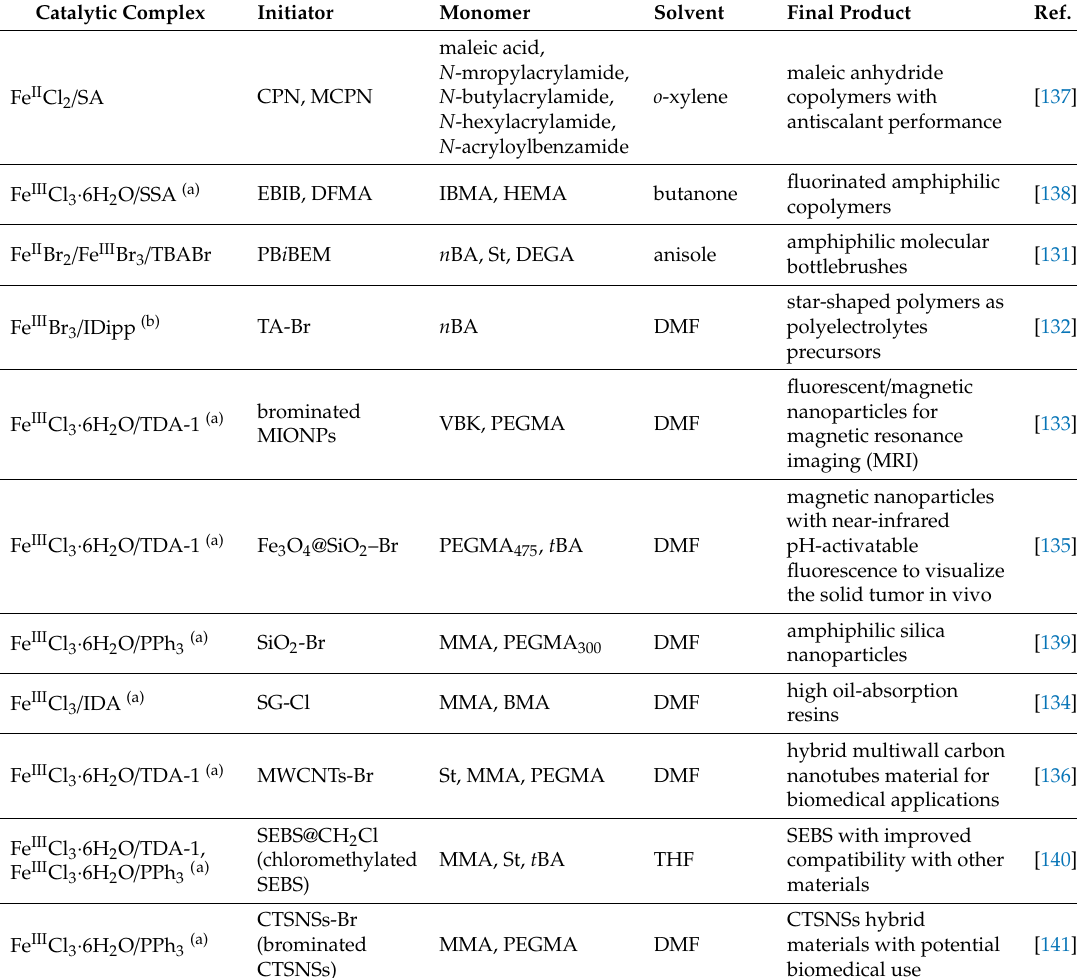
Table 3. Preparation of functional materials by of iron-mediated atom transfer radical